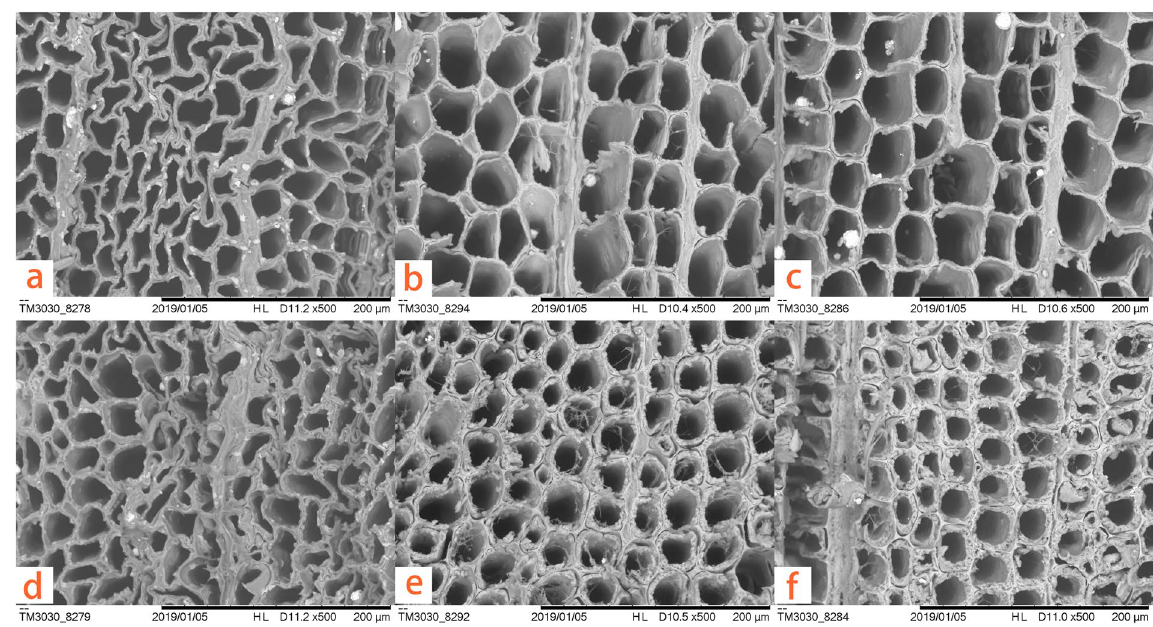
Figure 5. SEM micrographs of ( a,d ) untreated air-drying archaeological wood, ( b,e ) PSt grafted air-drying archaeological wood and ( c,f ) PBMA grafted air-drying archaeological wood, ( a–c ) for early wood part, ( d – f ) for late wood